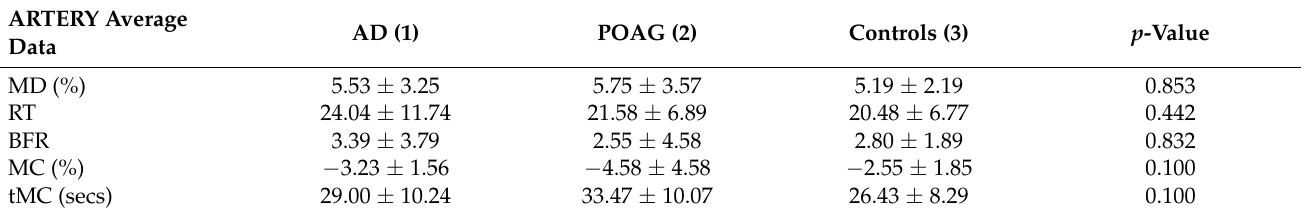
Table 2. Average Arterial Vascular Function Parameters Determined Using Dynamic Retinal Ves- sel Analysis.